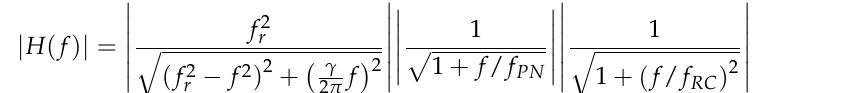
( b ) Figure 6. ( a ) The relationship between the relaxation oscillation frequency 𝑓 (cid:3045) and the square root of the bias current above the threshold, where the solid dots and lines are the experimental data and fitting results, respectively. ( b ) The relationship between the values of four-channel differen- tial gain and lasing wavelengths. 4. Conclusions A high-speed LC-DFB laser array based on a SiO 2 planarization process is demon- strated. Each channel exhibits a low threshold current of about 12 mA and a high slope efficiency over 0.26 W/A. Stable single mode operation is demonstrated with SMSRs over 45 dB. The small-signal 3-dBe bandwidths exceed 14 GHz for all four channels under in- jection currents of 100 mA. The high modulation bandwidth benefits from high differen- tial gain, and it can be further improved with a shorter cavity. Such results imply that the LC-DFB laser array can combine high efficiency slopes, high SMSRs, high modulation bandwidths and a simple fabrication process, and it shows great potential to low-cost op- tical communication. Author Contributions: Conceptualization, J.W. and Y.L.; data curation, Q.W.; formal analysis, Q.W.; funding acquisition, Y.L.; investigation, Q.W. and J.W.; methodology, Q.W. and C.S.; project administration, Y.L.; resources, C.S. and Y.H.; supervision, Y.L.; validation, B.X., Z.H., L.W., H.L. and J.Y.; visualization, Q.W.; writing—original draft, Q.W.; writing—review and editing, Q.W. and J.W. All authors have read and agreed to the published version of the manuscript. 0